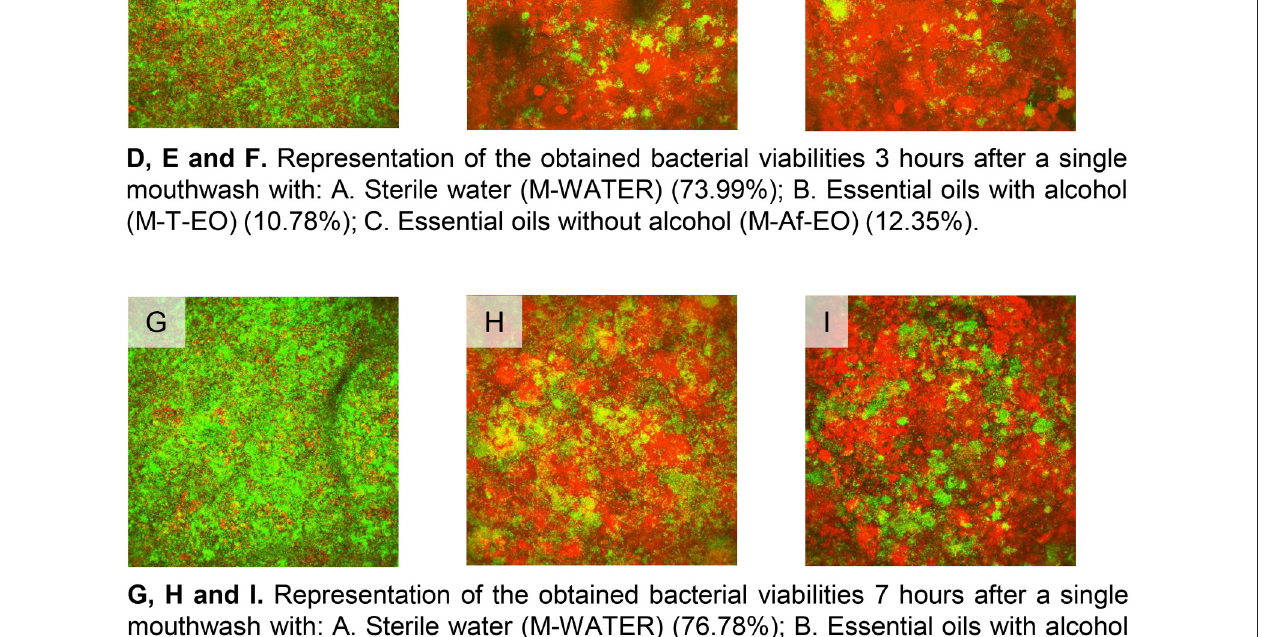
Frontiers in Microbiology |